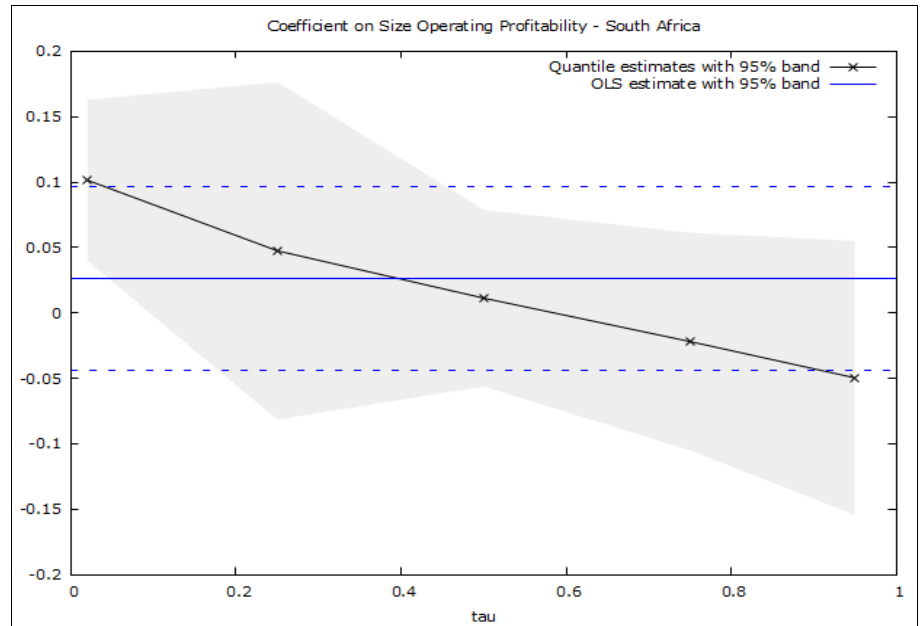
Figure A1. Performance of the SMB OP risk factor on the percentiles and conditional average of South Africa ’ s GDP growth rate.